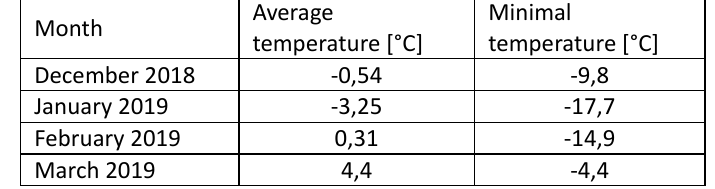
Table 1: The average temperatures in Žďár nad Sázavou during the winter